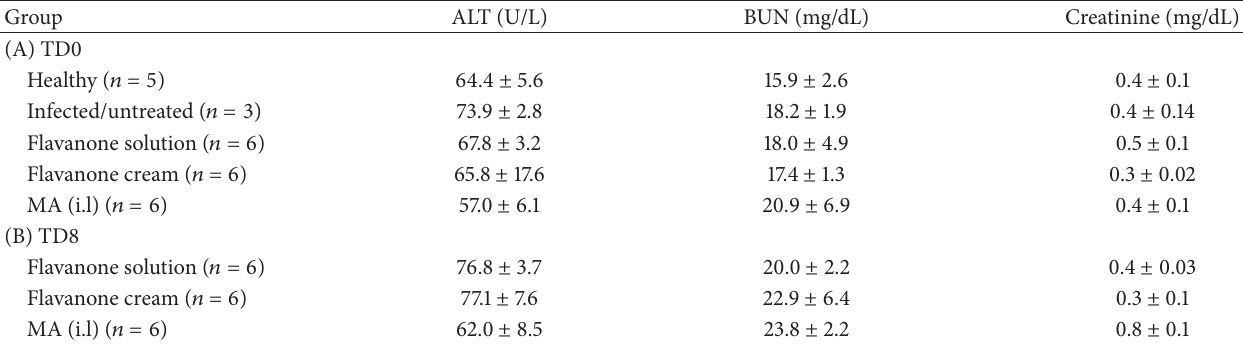
Table 2: Blood levels of ALT, BUN, and creatinine in hamsters treated with 5,3 󸀠 -hydroxy-7,4 󸀠 -dimethoxyflavanone